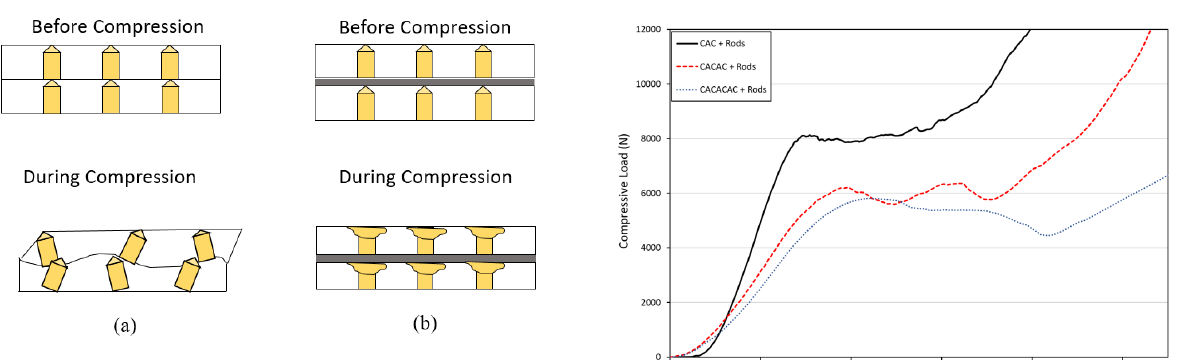
Figure 11: Sketches illustrating cardboard panels reinforced with rods without aluminum support (a) and with aluminum support (b) before and during compression. Aluminum support is required for effective load transfer and uniform crushing of adjacent layers. layer (CACACAC + Rods) are presented in Figure 12. Data from panels with two layers of cardboard and one sheet of aluminum in between is also included for comparison. The maximum load for both three and four-layer card- board panels is approximately the same at 6000 N, which is significantly less than that of CAC + Rods at 8000 N.